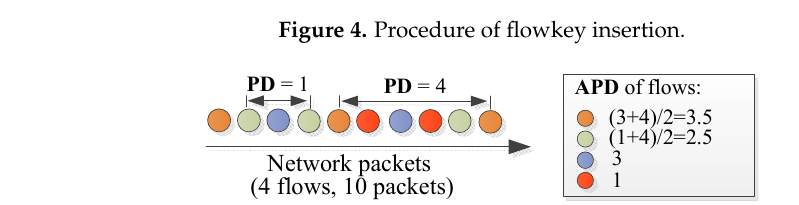
Figure 5. Illustration of packet distances of network flows.